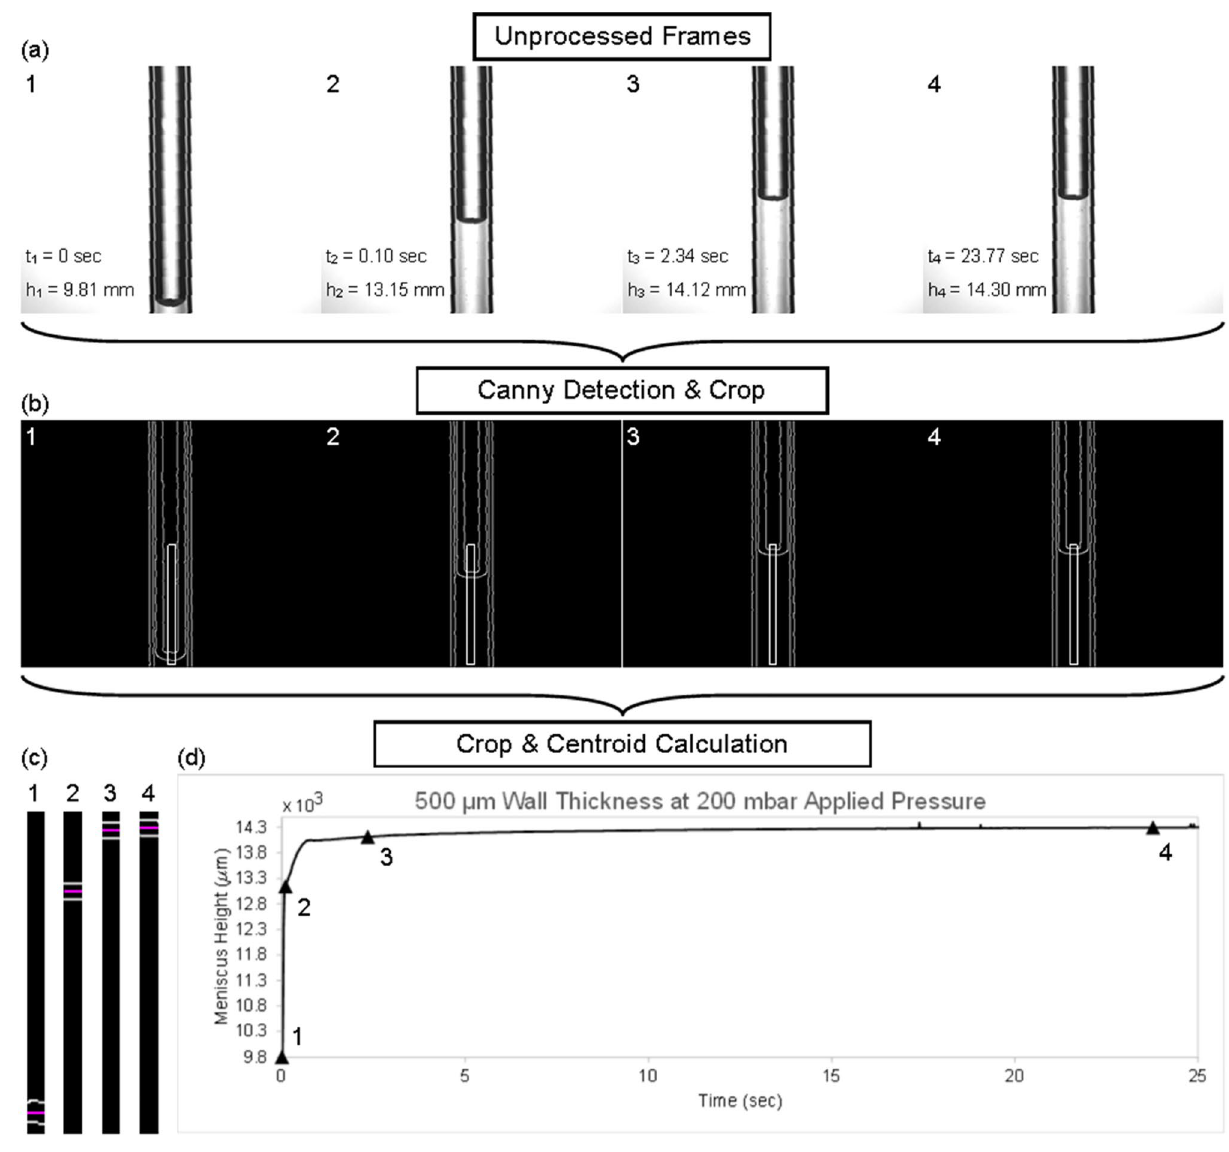
Figure 2. ( a ) Frames are collected at 60–10 Hz and are rotated so the 1.2 mm ID glass capillary is upright. The frames need to be high contrast for ( b ) Canny edge detection. The meniscus at initial and maximum height is ( c ) cropped on each image. Centroid calculations are performed to find the meniscus height at each frame. ( d ) Each frame height is compiled together to form an output plot. Note: The data points in this figure show the actual meniscus